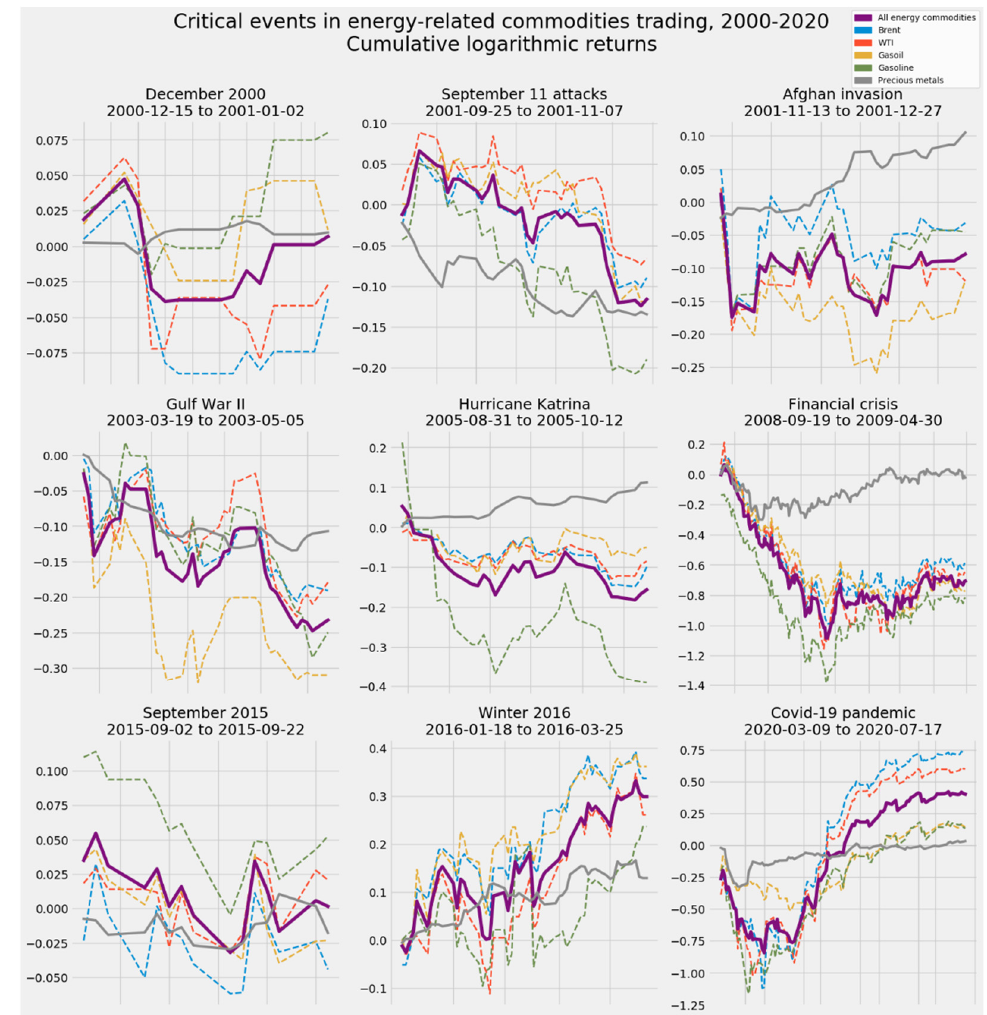
Figure 39. Cumulative logarithmic returns during critical periods for an equally weighted market basket of four oil and fuel commodities, with details for each of the constituent markets. Cumulative log returns on precious metals are shown for purposes of comparison.